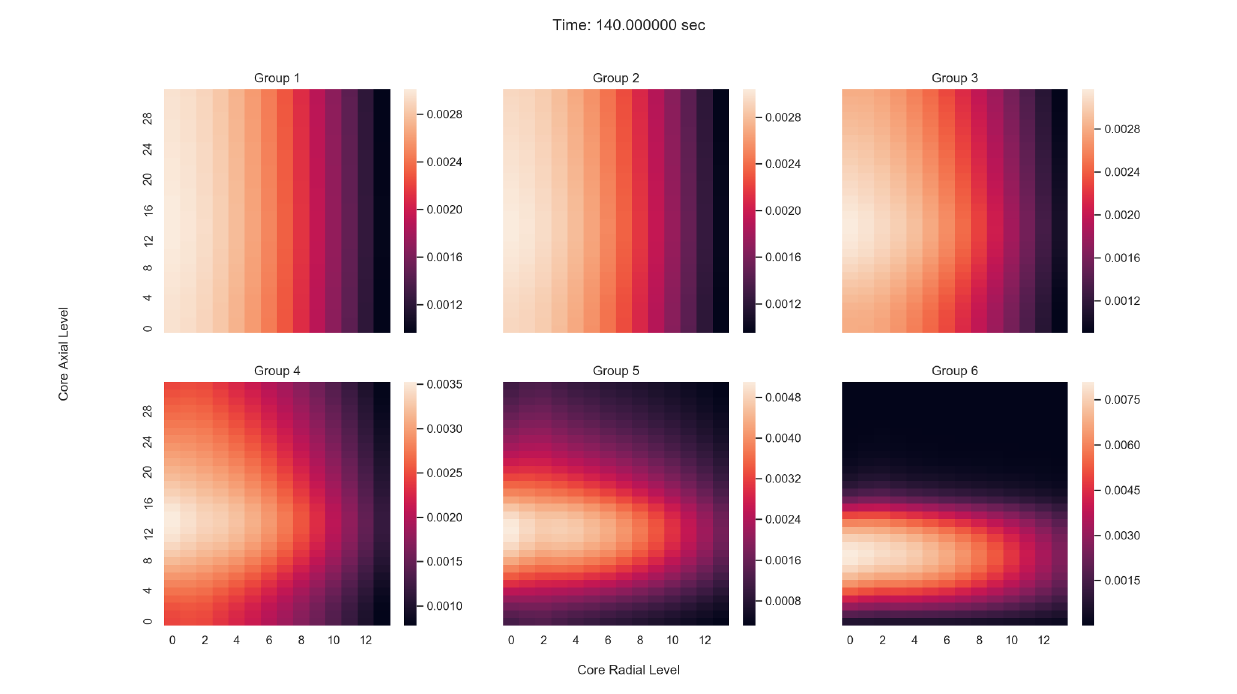
Figure 7: Normalized Neutron Precursor